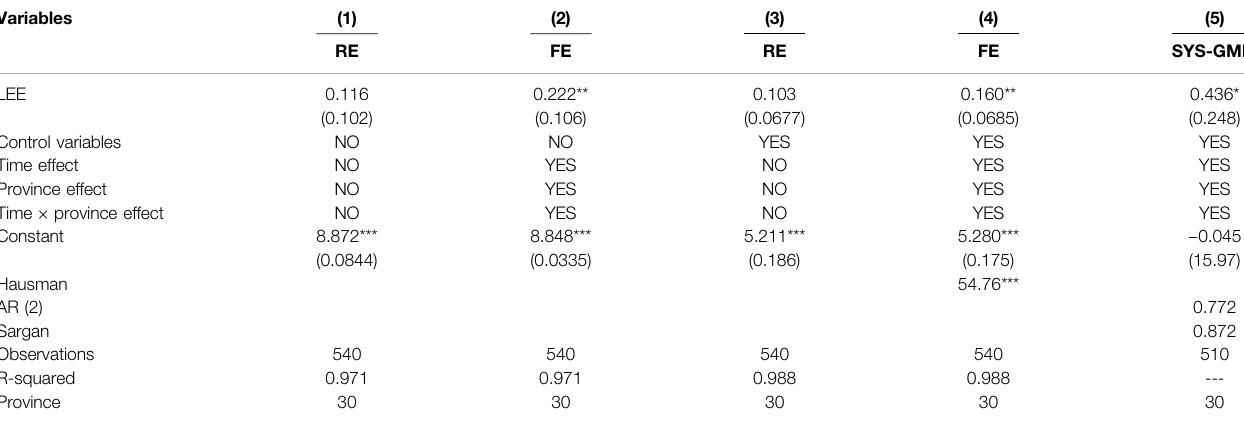
TABLE 4 | Effects of LEE on economic growth.